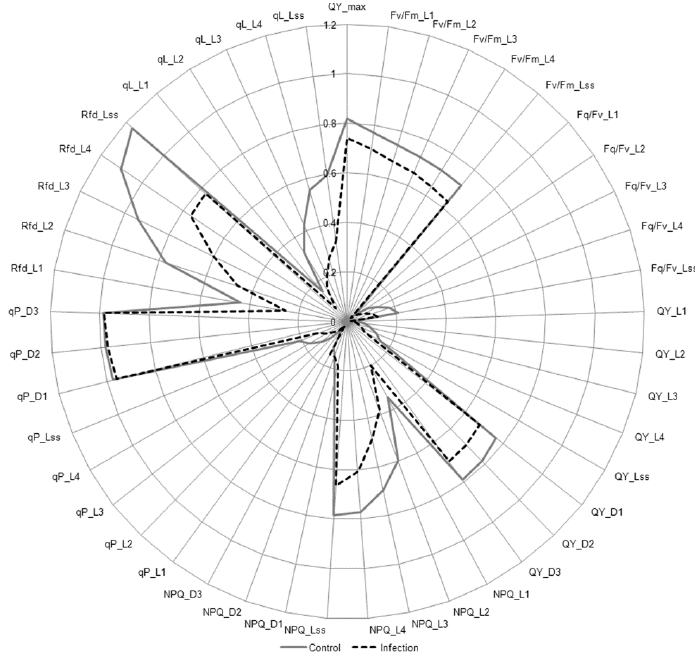
Figure 10. Analysis of chlorophyll a fluorescence parameters in B. oleracea leaves infected with A. brassicicola at 48 hpi. Values are the means obtained in 3 independent experiments ( n = 3; detailed analysis is available in Table S6).